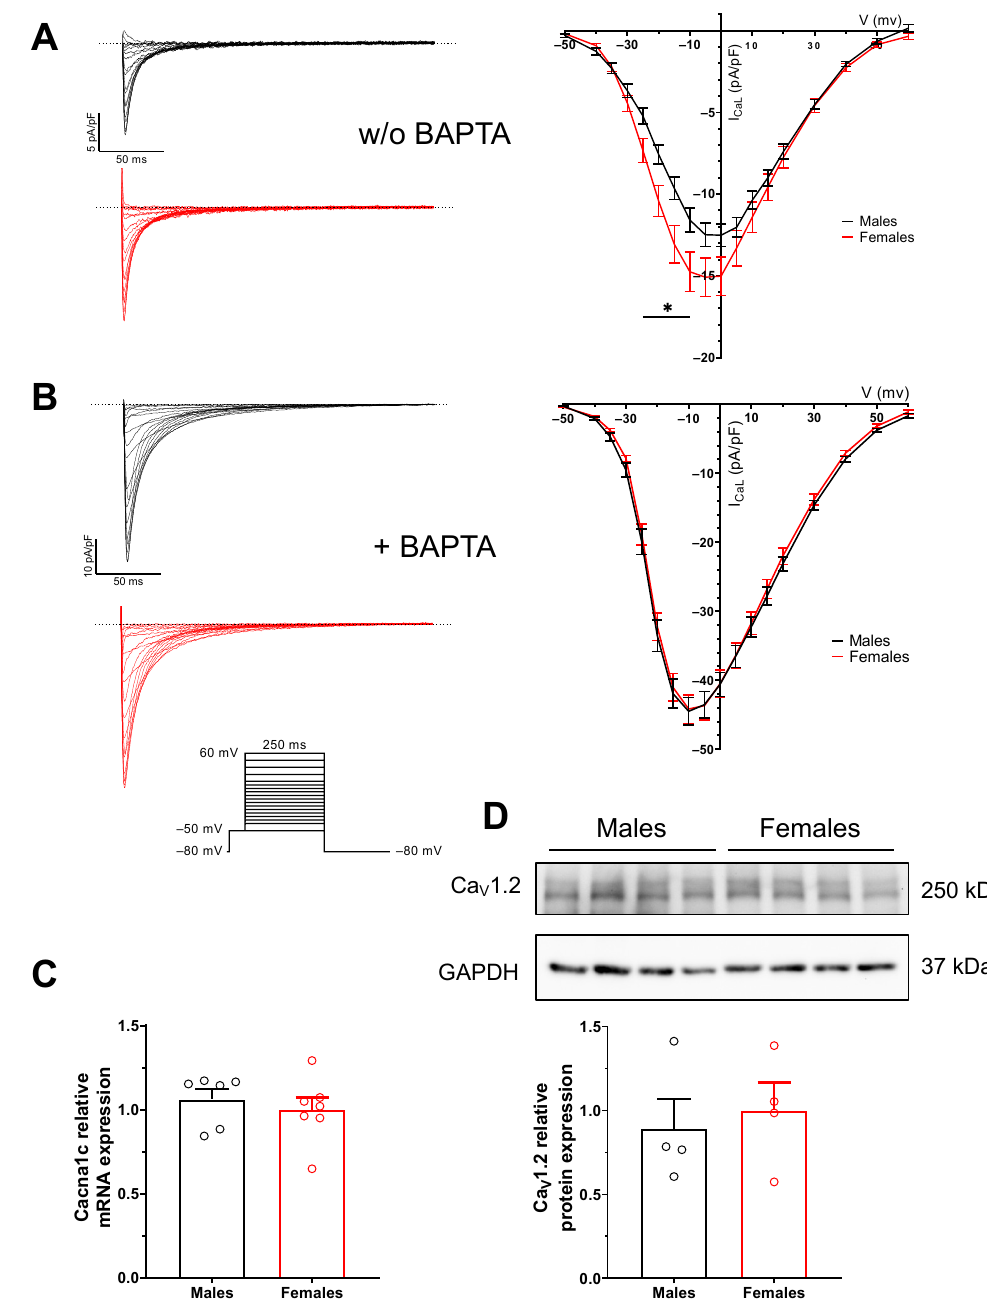
Figure 5. Similar I CaL density and Ca V 1.2 expression in male and female mouse atria. ( A ) Left: Typical recordings of I CaL from male (black) and female (red) atrial myocytes in the absence of BAPTA (inset displays the voltage protocol). Dotted line represents the zero current . Right: Mean IV curves of I CaL show a lower current density in males (* p ˂ 0.05 from –25 to − 10 mV; M: n = 22, N = 3; F: n = 21, N = 2). ( B ) Left: Typical recordings of I CaL from male (black) and female (red) atrial myocytes with 10 µM BAPTA in the pipette solution. Right: Buffering of intracellular Ca 2+ by BAPTA abolishes the difference in I CaL density between males and females, as shown on mean IV curves ( p > 0.05 at all voltages; M: n = 26, N = 2; F: n = 25, N = 2). ( C ) The mRNA expression of Cacna1c (underlying Ca V 1.2) is similar in male and female atria (M: 1.06 ± 0.06, n = 6; F: 1.00 ± 0.07, n = 7; p = 0.6). ( D ) Densitometry analysis of Western blot of Ca V 1.2 reveals that protein expression is similar in male and female atria. GAPDH was used as a loading control, for normalization (M: 0.89 ± 0.18, n = 4; F: 1.00 ± 0.17, n = 4; p = 0.7).